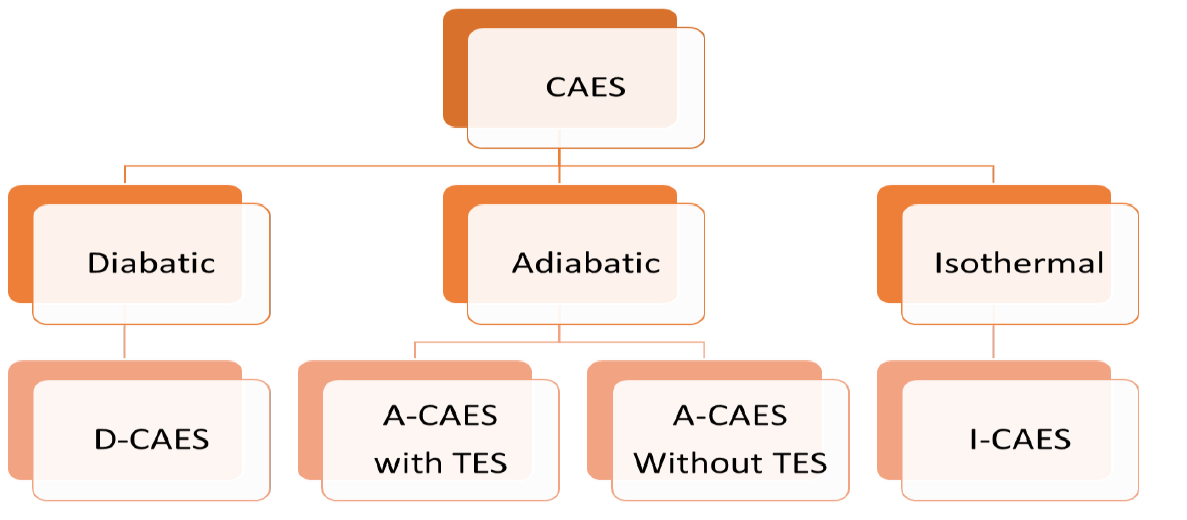
Figure 4. CAES classification.